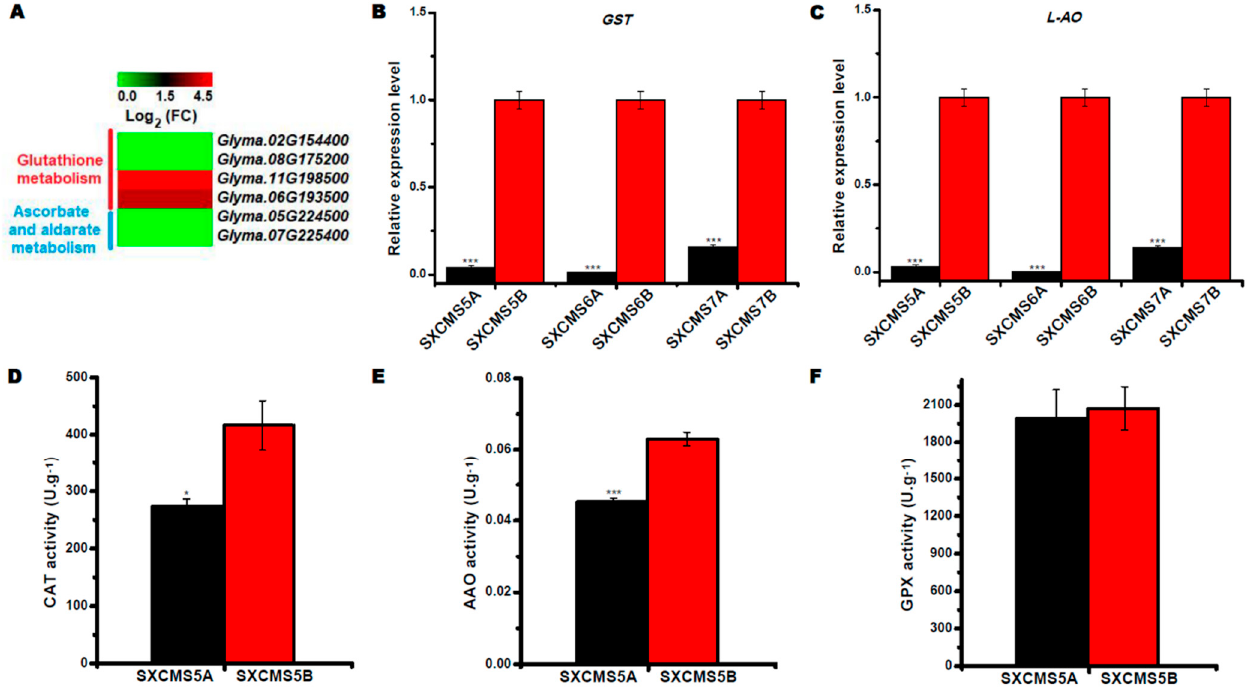
Figure 7. Analysis of DEGs related to reactive oxygen species (ROS) metabolism between soybean CMS lines and their maintainers. ( A ) Heat map of the DEGs related to glutathione metabolism and ascorbate and aldarate metabolism between SXCMS5A and SXCMS5B. The heat map was created using MeV 4.9 software. Log 2 (FC) values were obtained from RNA-seq data. ( B , C ) Relative expression level of Glutathione S-transferase-like ( GST , Glyma.02G154400 ) and L-ascorbate oxidase homolog ( L-AO , Glyma.07G225400 ) between soybean CMS lines and their maintainers by qRT-PCR analysis. ( D – F ) Activity assays of catalase (CAT), ascorbic acid oxidase (AAO) and glutathione peroxidase (GPX) between SXCMS5A and SXCMS5B. Asterisk indicated statistical significance: *, p < 0.05; ***, p < 0.001.